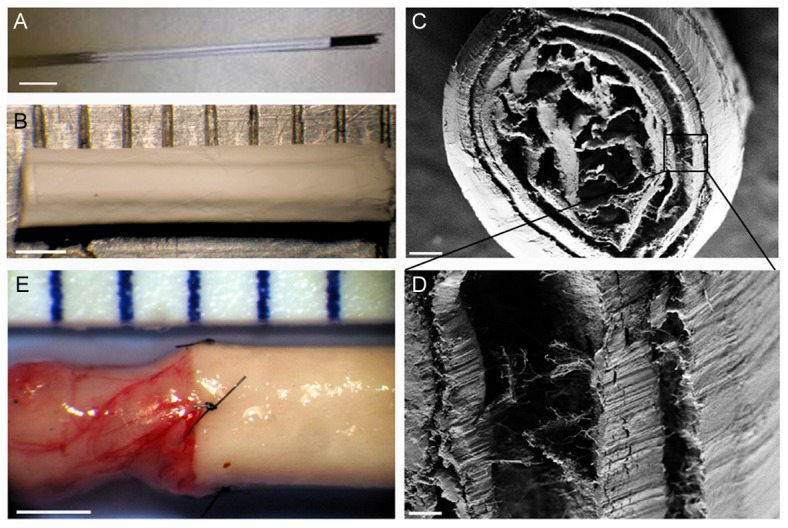
Development of a multifunctionalized nanofiber-based tube for in vivo implantation.Fibroin scaffold is collected at the end of the electrospinning process and rolled up on teflon sticks (A), higher magnification of the designed fibroin tube (B), SEM observation of a cross section of the fibroin tube (C), higher magnification highlighting the alignment of nanofibers inside the tube (D) and nanofiber-based tube sutured to a rat sciatic nerve (E). Scale bar: 1 cm A), 1 mm B and E), 200µm C) and 30µm D). For details see material and methods.